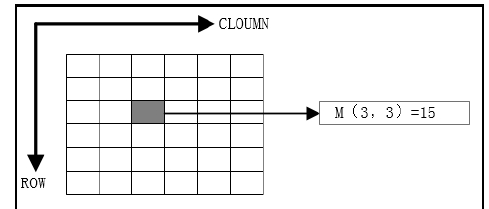
Figure 1.Schematic diagram of raster data to Morton code